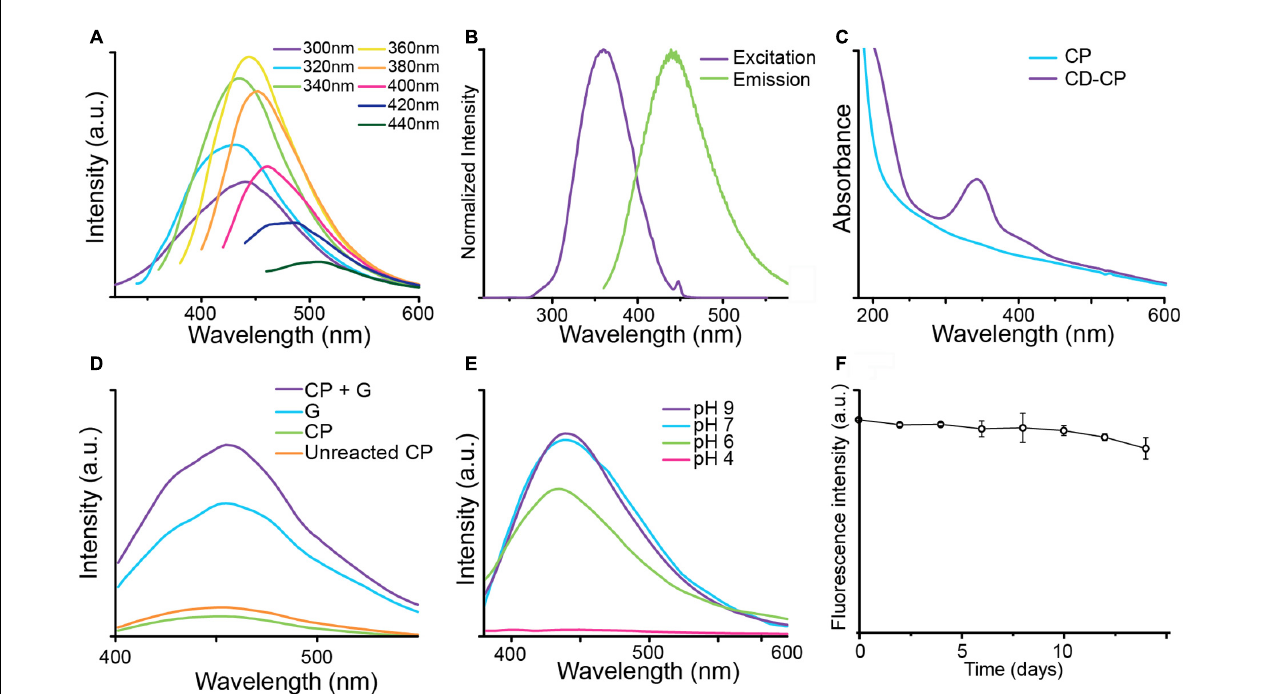
FIGURE 4 | Optical properties of CNPCP. (A) Fluorescence emission spectra generated under different excitation wavelengths. The CNPCP display a strong fluorescence in the green-blue range of the spectrum. (B) Fluorescence excitation (purple) and emission (green) profiles of CNPCP. (C) UV-Vis absorbance spectra of CP and CD-CP. The CD-CP shows an absorbance peak around 340 nm, indicating the presence of CDs on the NPs. (D) Fluorescence emission from microwaved solutions of chitosan-PEG and glucosamine (CP + G), glucosamine (G), chitosan-PEG (CP), and unmodified chitosan-PEG (Unreacted CP). (E) Fluorescence spectra of CNPCP in aqueous solutions of various pH values. (F) Fluorescence intensity of CNPCP in DMEM incubated at 37 ◦ C over time.